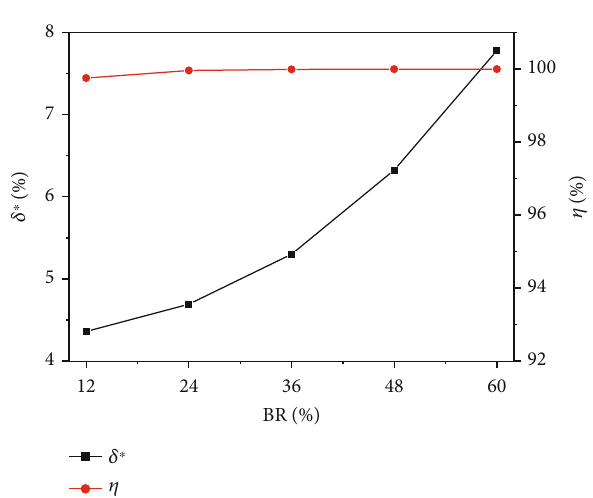
Figure 8: Total pressure loss and combustion e ffi ciency under di ff erent